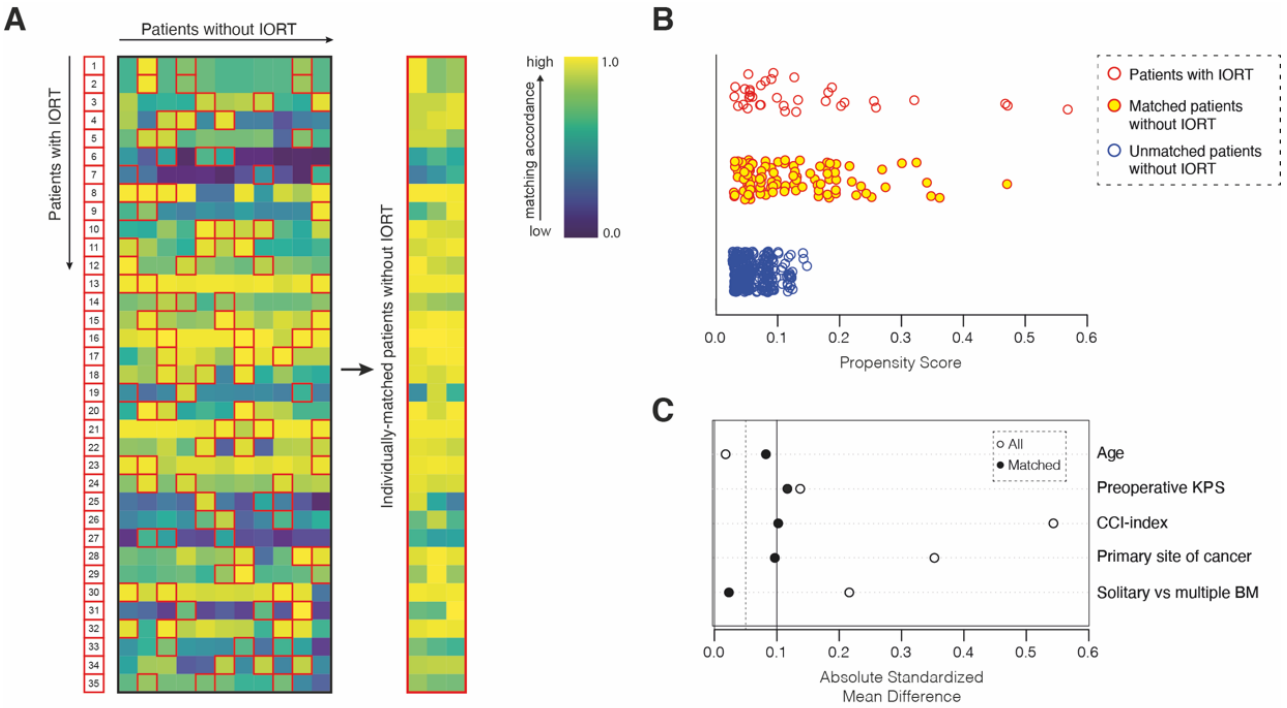
Figure 1. Illustration of the matching procedure for patients with surgically treated BM dependent on the presence of IORT. ( A ) Comparative matched-pair analysis at a ratio of 1:3 identified 105 out of 388 patients with surgically treated BM without IORT that individually corresponded to the present series of 35 patients with surgically treated BM combined with IORT. Heat map is a color-coded illustration of the matching strategy of patients without IORT to individually matched IORT cases by means of age at admission, KPS at admission, CCI at admission, and tumor entity and solitary versus multiple BM as matching parameters. Red frames depict individually matched patients without IORT. ( B ) Visualization of obtained propensity scores for matched and unmatched patients with BM. ( C ) Love plot depicting the balance of the matching analysis for each matching parameter determined by the standardized mean differences. BM, brain metastasis; CCI, Charlson comorbidity index; IORT, intraoperative radiotherapy; KPS, Karnofsky performance score. Table 3. Comparative matched-pair analysis on perioperative complication profiles for patients with versus without IORT.